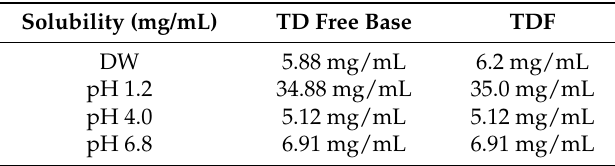
Table 4. pH dependent TD free base and TDF